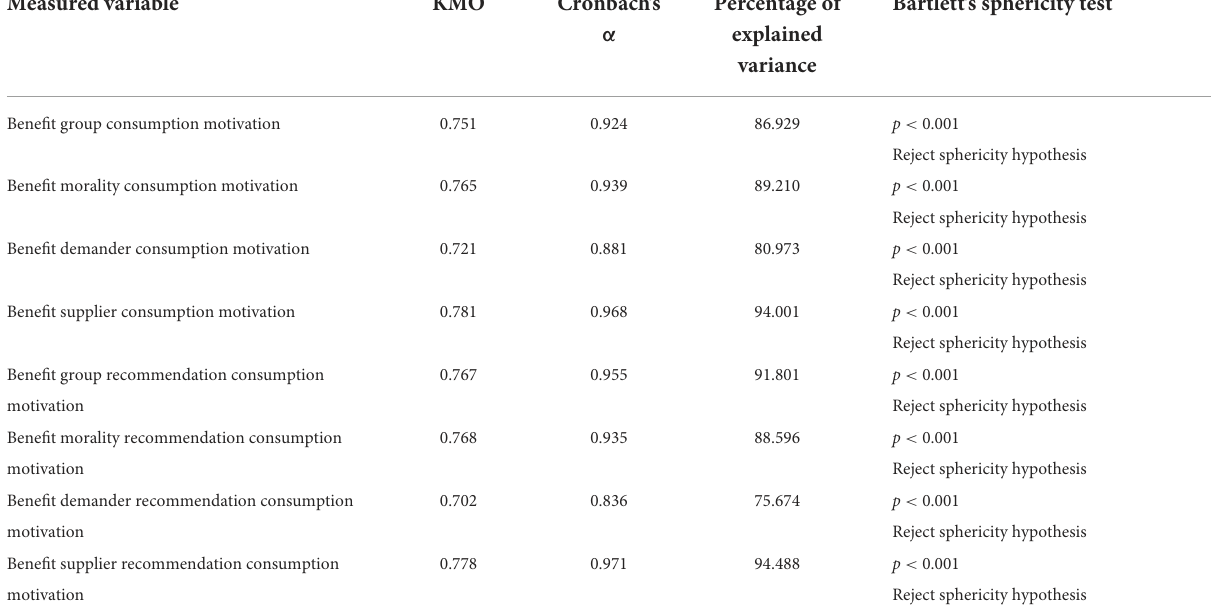
TABLE 2 Reliability and validity